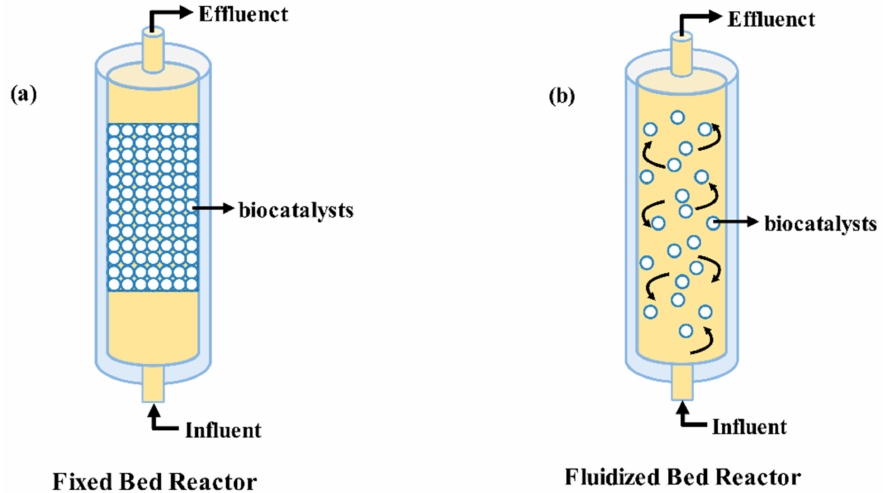
Figure 4. Schematic diagram of fixed bed reactor and fluidized bed reactor: ( a ) fixed bed reactor, ( b ) fluidized bed